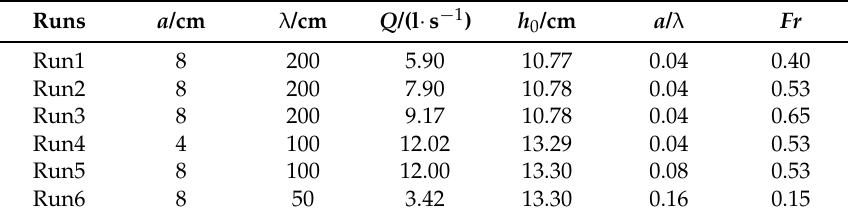
Table 1. Summary of Flow Conditions in Experiment.